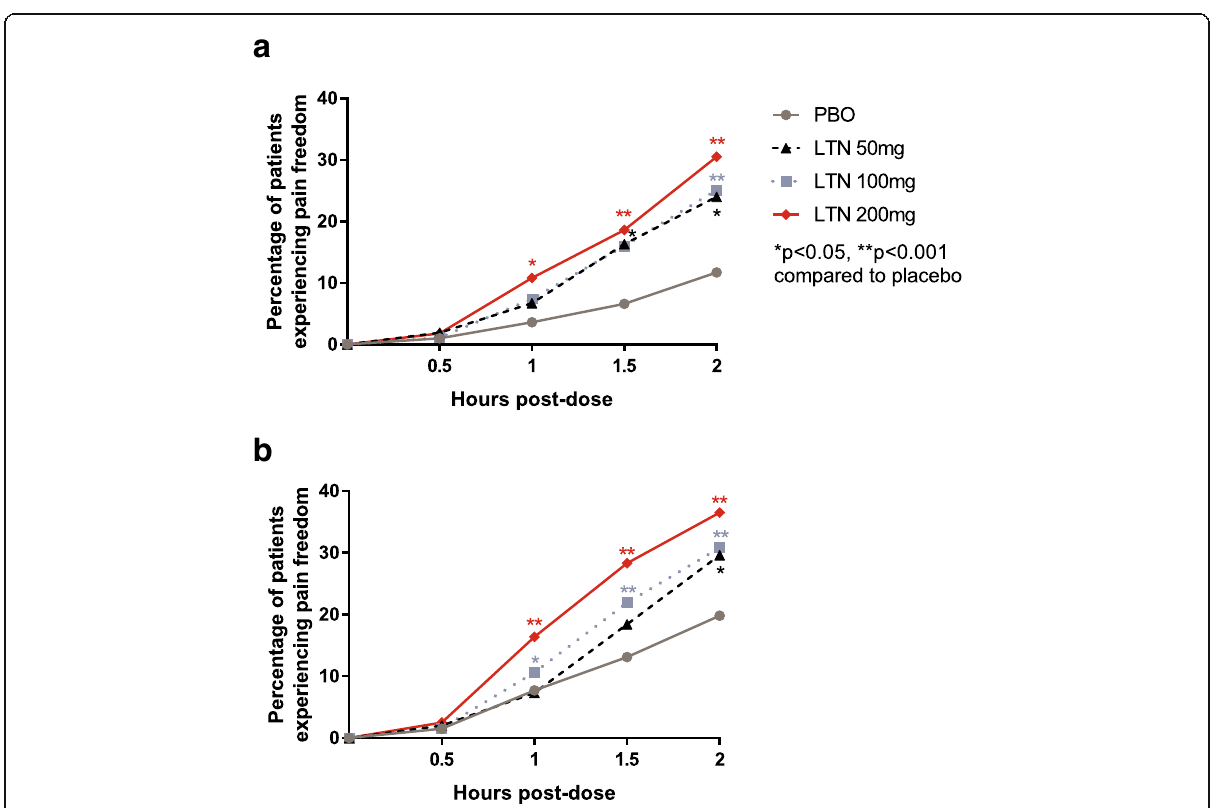
Fig. 2 Pain freedom occurred at similar time points in patients using versus not using preventive medications. Patients using ( 2a ) and not using ( 2b ) migraine preventive medications treated a migraine attack with lasmiditan (LTN) 50 mg, 100 mg, or 200 mg of or placebo (PBO). They then rated their pain at 0.5, 1, 1.5, and 2 h postdose. The percentages of patients reporting no pain at each time point are shown in the graph. * p < 0.05 compared to PBO, ** p < 0.001 compared with